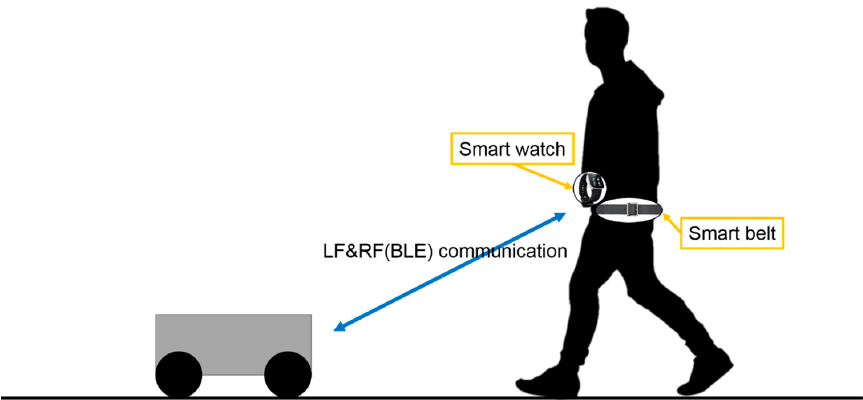
Figure 2. Overall setup of the Pet-Bot system.